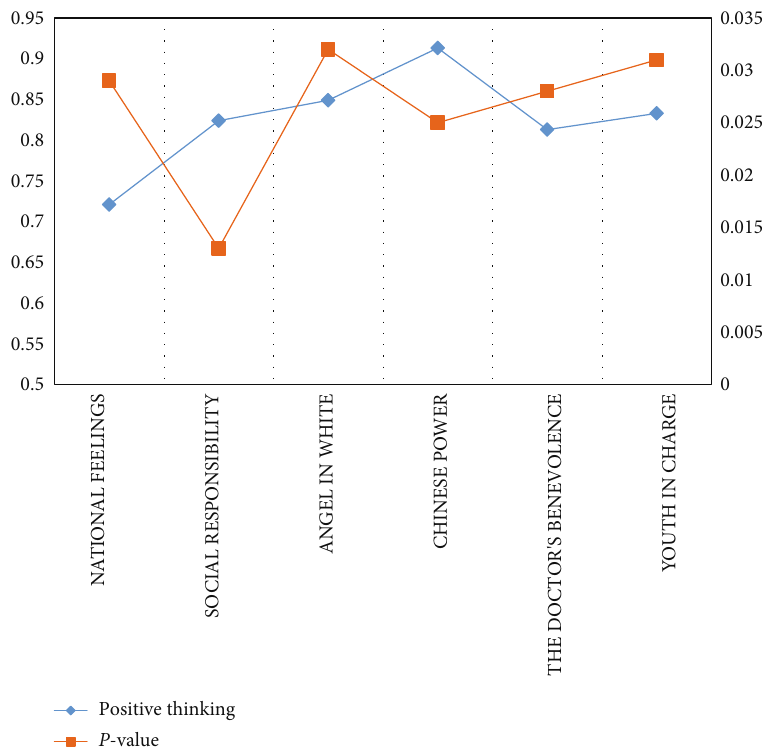
Figure 11: Analysis of the correlation between hot spots and ideological dynamics during the